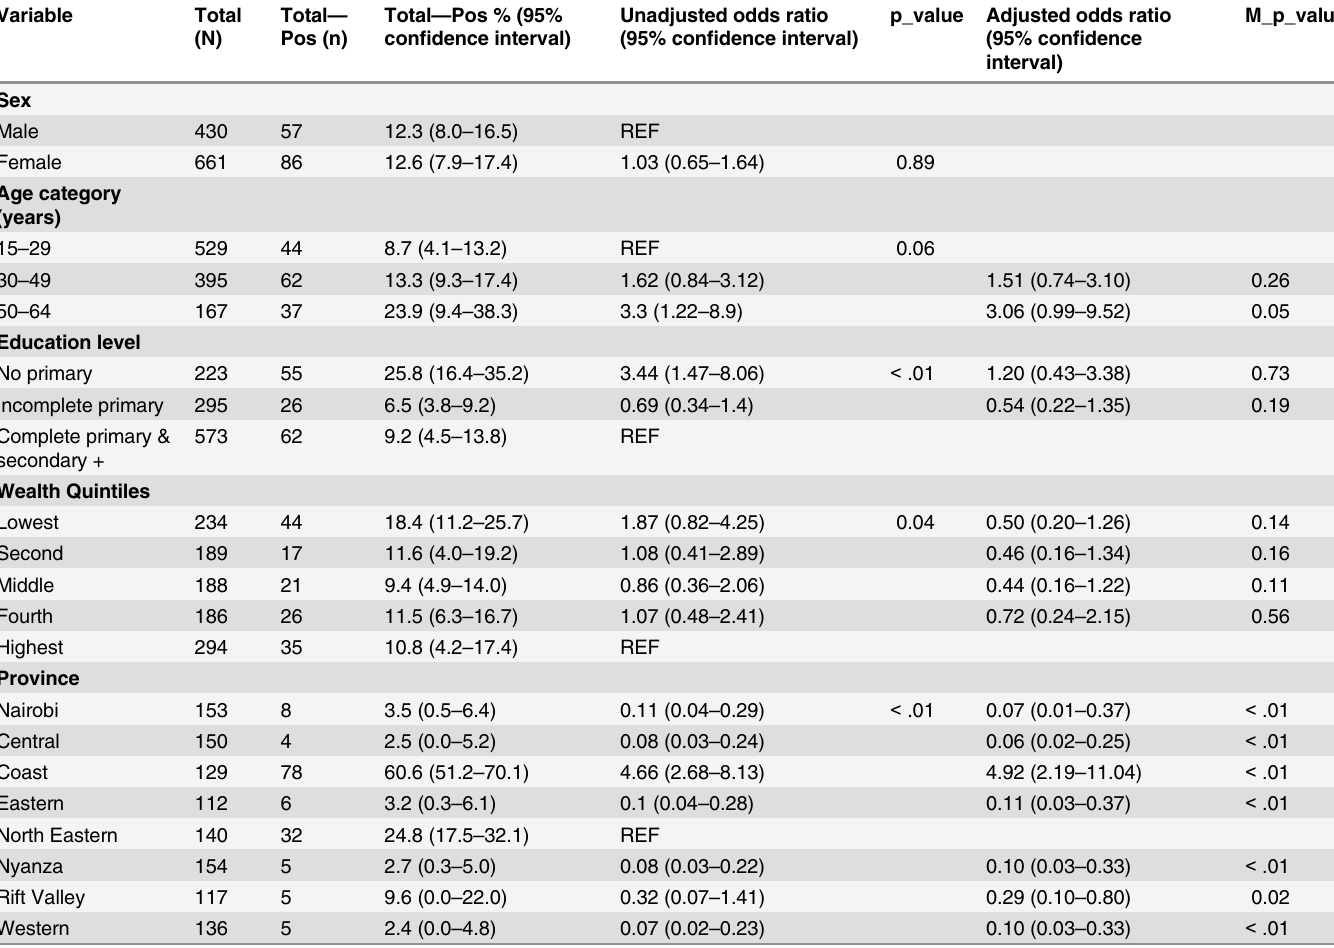
Table 2. Prevalence and factors associated with dengue virus among persons aged 15 – 64 years, Kenya,